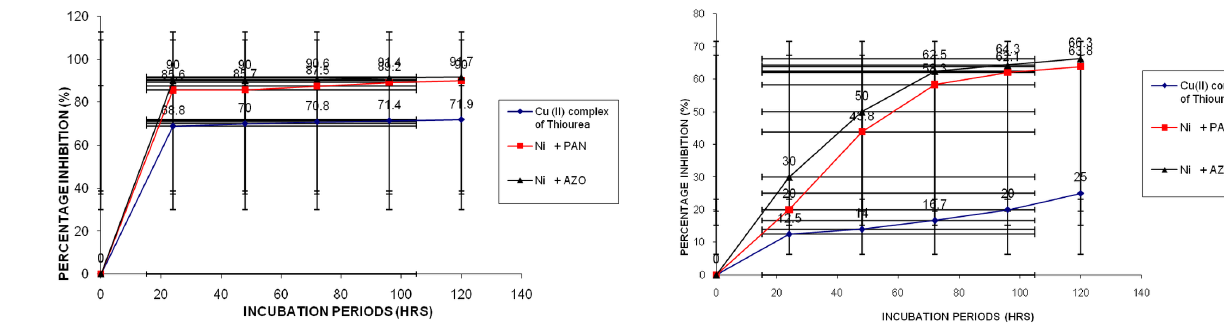
Fig. 2. Reduction of Mycelial growth of Geotrichum candidum at 1.0 mg/ml